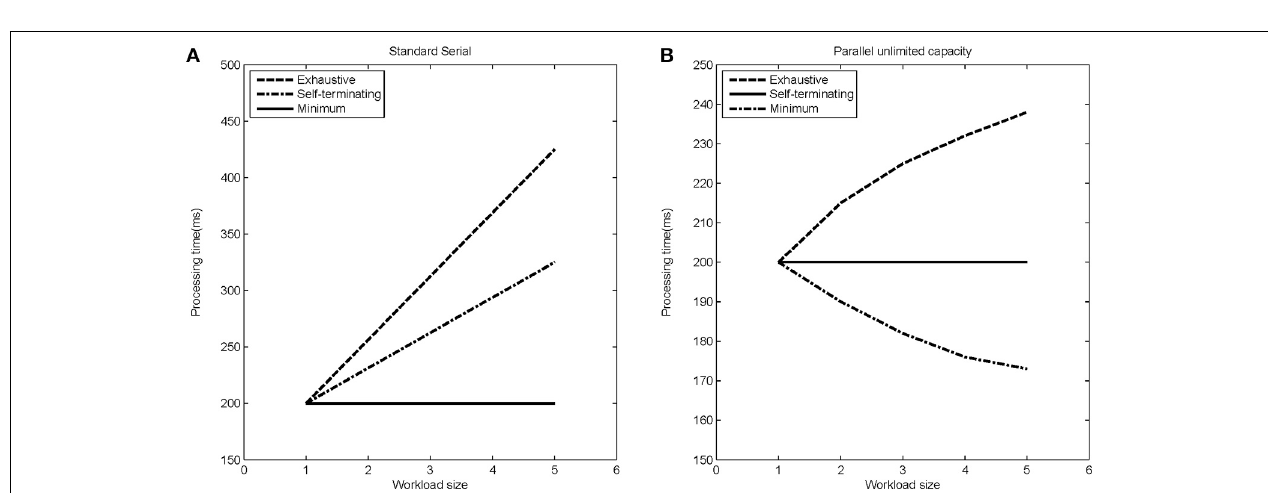
FIGURE 4 | Graphical intuition of a system’s behavior under different capacity bounds: unlimited capacity, limited capacity, and supercapacity.